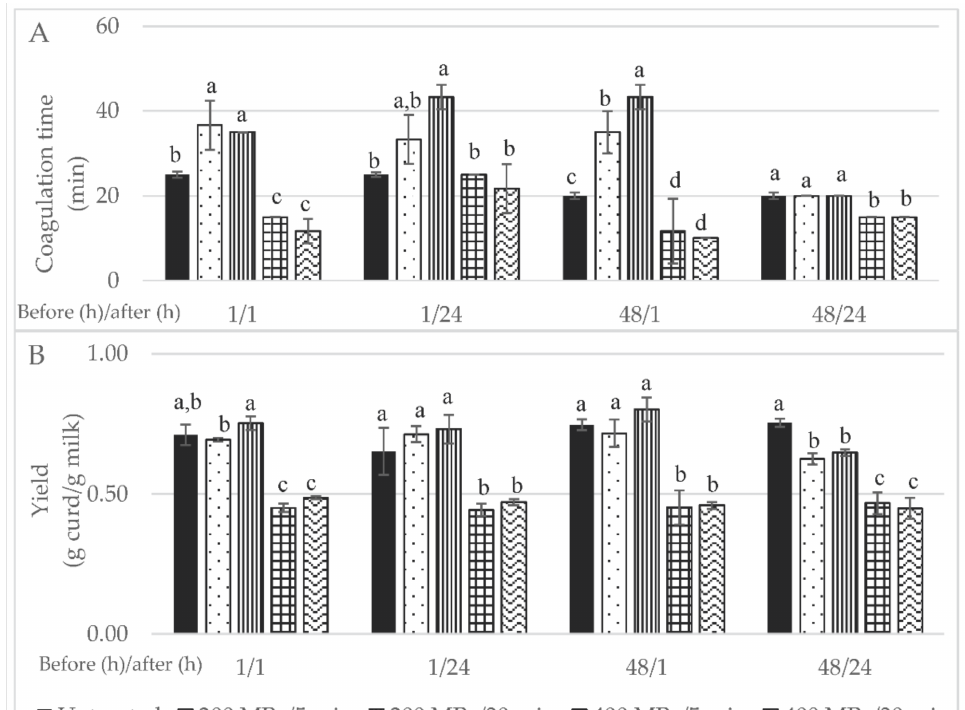
Figure 2. Initial wide screening results for: ( A ) coagulation time (in min) and ( B ) yield expressed in g of curd per g of milk; 1/1—milk high-pressure processing (HPP)-treated and transformed within the day of collection; 1/24—milk HPP-treated on day of collection and transformed the next day; 48/1—milk HPP-treated after 48 h of collection and subsequently transformed on the same day; 48/24—milk HPP-treated after 48 h of collection and transformed after 24 h; control samples are untreated milk. Different non-capital letters (a, b, c) indicate statistically significant differences for the same waiting time ( p < 0.05) between treatment